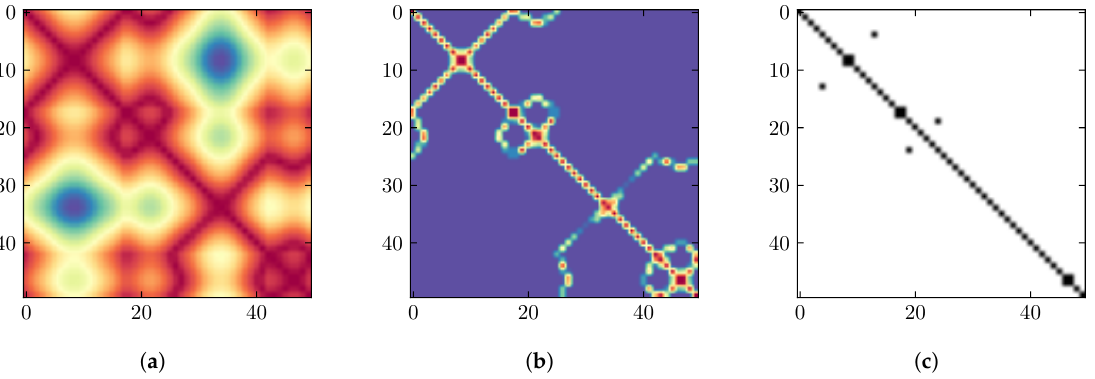
Figure 4. Generation of distance similarity matrix and RGs for a vacuum cleaner activation current in PLAID dataset: ( a ) Distance similarity matrix D w